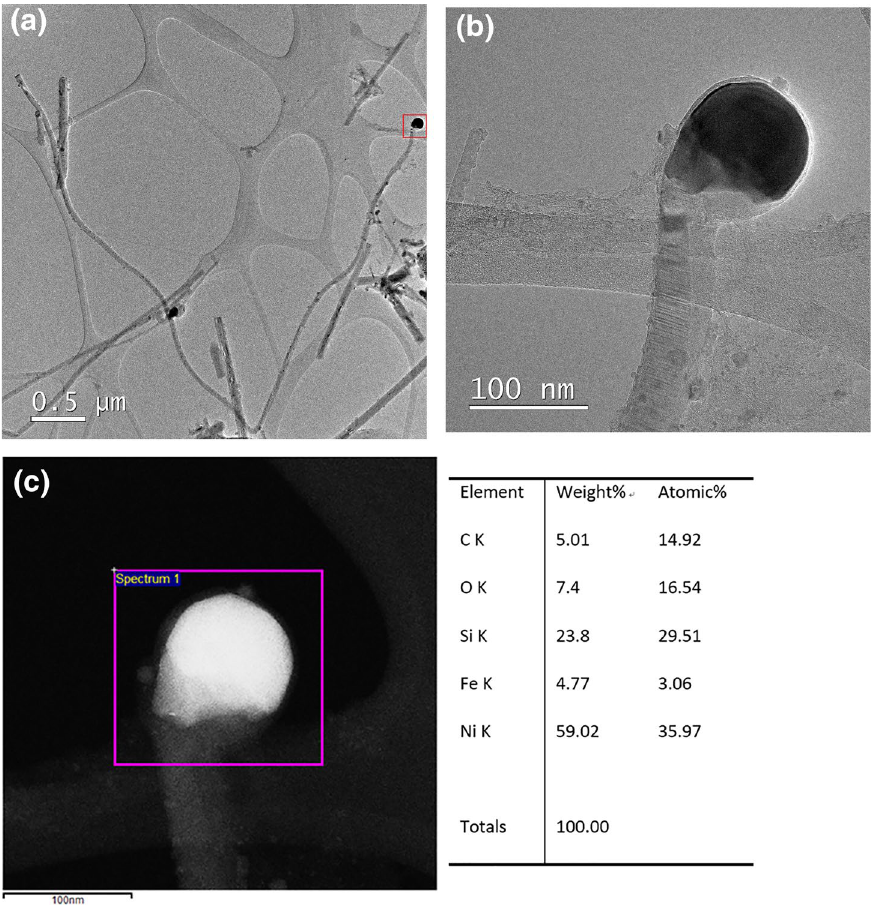
Figure 3. ( a ) The low-magnification TEM image of as-synthesized nanowires. ( b ) The high-magnification TEM image of the selected area marked by the red rectangle in ( a ). ( c ) The EDS pattern of the catalyst